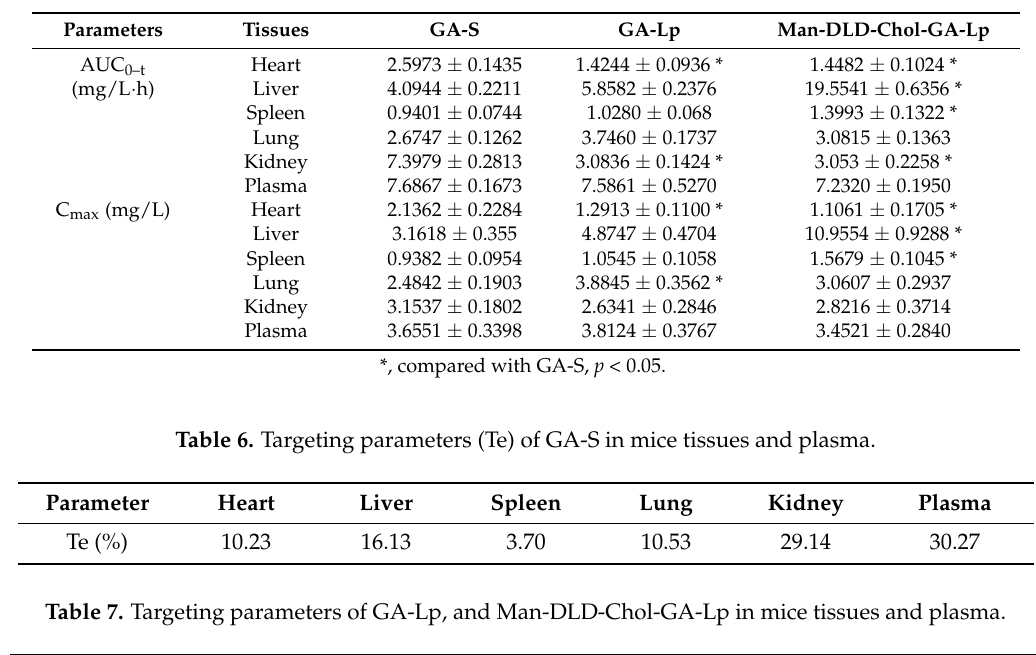
Table 5. Pharmacokinetic parameters of GA-S, GA-Lp, and Man-DLD-Chol-GA-Lp in mice’s tissues and plasma (mean ± SD, n = 5).